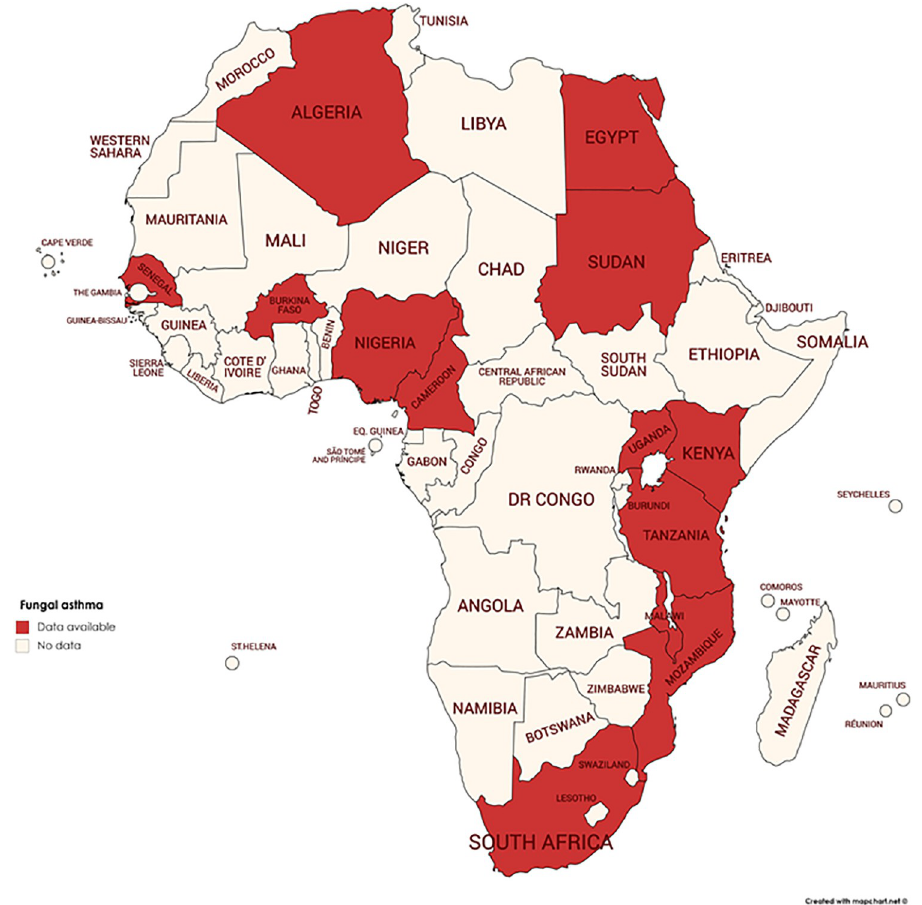
Fig 3. Distribution of studies describing burden of fungal asthma in Africa. Twenty studies were found from thirteen (out of 54) African countries. The shaded areas represent countries with data from epidemiological study and/ or review article. Map was created and reprinted from [https://mapchart.net/africa.html#] under a CC BY